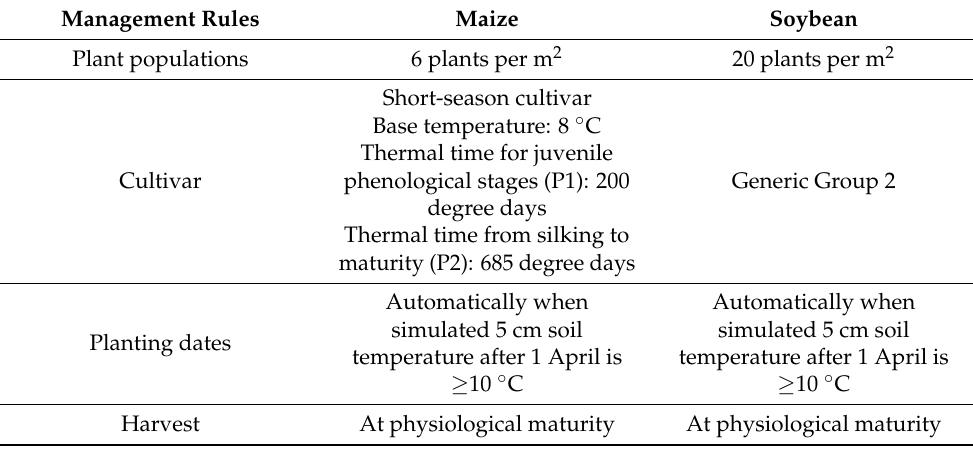
Table 1. The cropping management options for maize and soybean used for the Decision Support System for Agrotechnology Transfer (DSSAT)